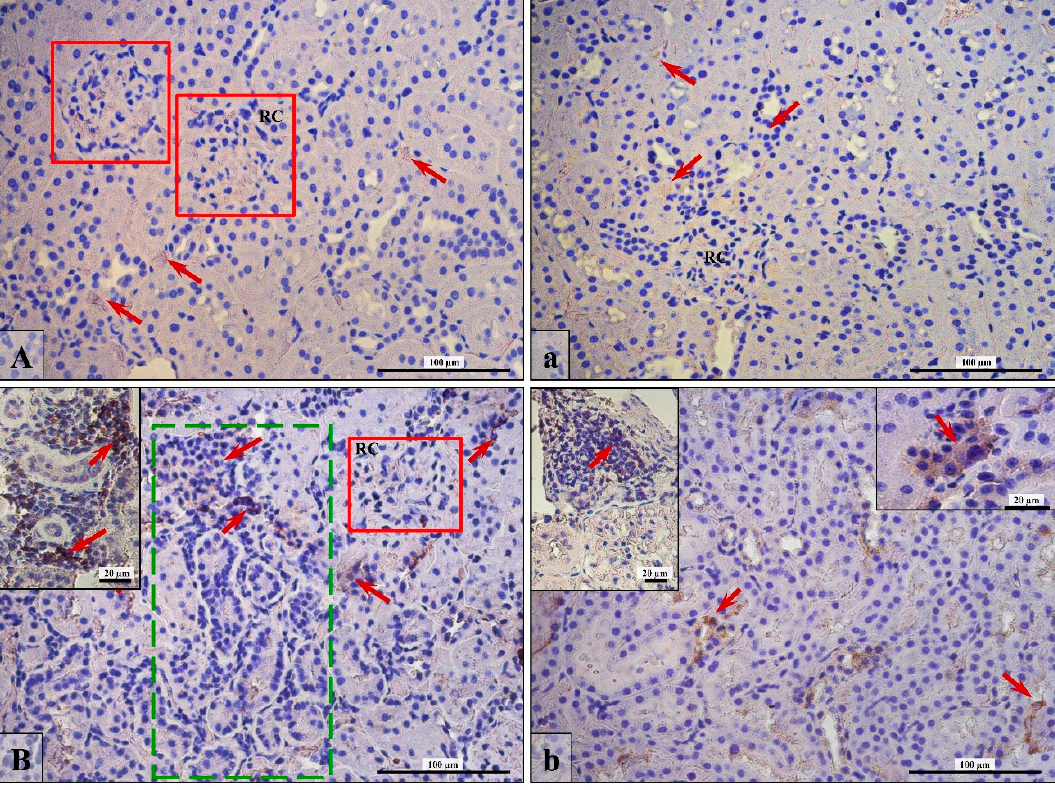
Figure 4. Brown pigmentation of a positive IHC reaction that indicates expression of CD3 ( A , B ) and CD19 ( a , b ) in kidney cells of Control ( A , a ) and Fin ( B , b ) groups of rats. In control rats, a kidney CD3-positive area was weakly visible in the renal corpuscle ( A; RC; red frame ), and CD19 positive cells were visible among interstitial tissue or epithelial cells ( a; red arrows ). In finasteride-treated rats, the DC3- ( B ) and CD19-positive cells ( b ) were marked by red arrows; the green frame indicates the pathologically changed area with renal convoluted tubules ( B ). Scale bars in A, a, B, and b are 100 µ m; scale bars in insertion in B and b are 20 µ m.